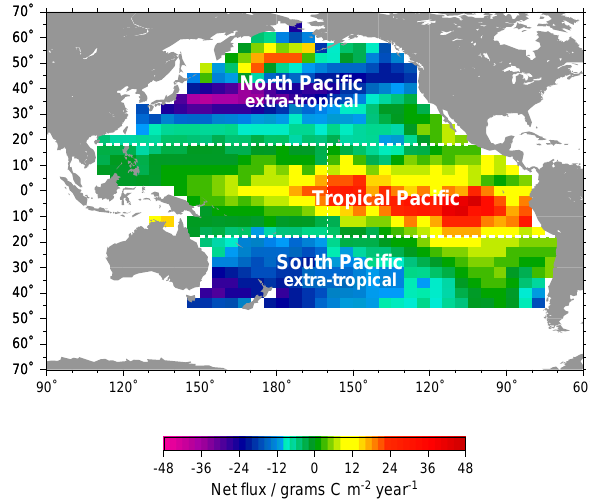
Fig. 5. Three Pacific Ocean sub-basins defined according to the ag- gregation of 14 Pacific regions of the ocean-interior CO 2 inversions (Mikaloff Fletcher, 2006). Superposed is the mean annual air–sea CO 2 flux for the year 2000 calculated with climatological p CO 2 sw of LDEO V2009 (Takahashi et al., 2009a) and CCMP wind (Ardiz- zone et al., 2009; Atlas et al., 2011). Positive fluxes are out of ocean and negative fluxes are into the